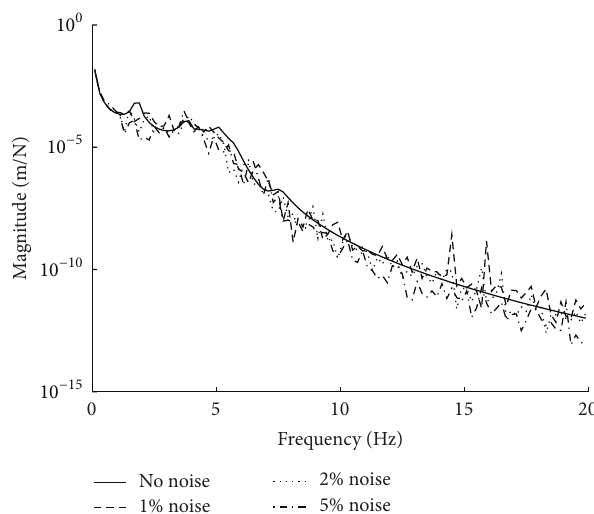
Figure 6: Effect of random noise of measured system-level FRFs on the predicted frequency response function from 𝑚 9 to 𝑚 1